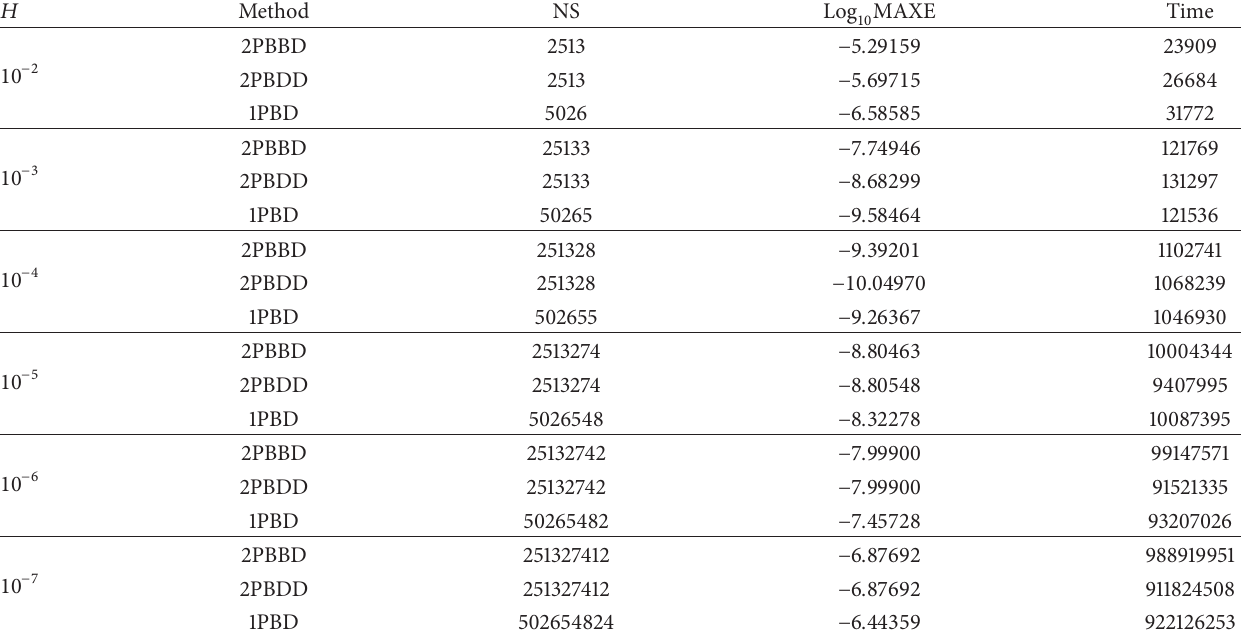
Table 7: Numerical result for Problem